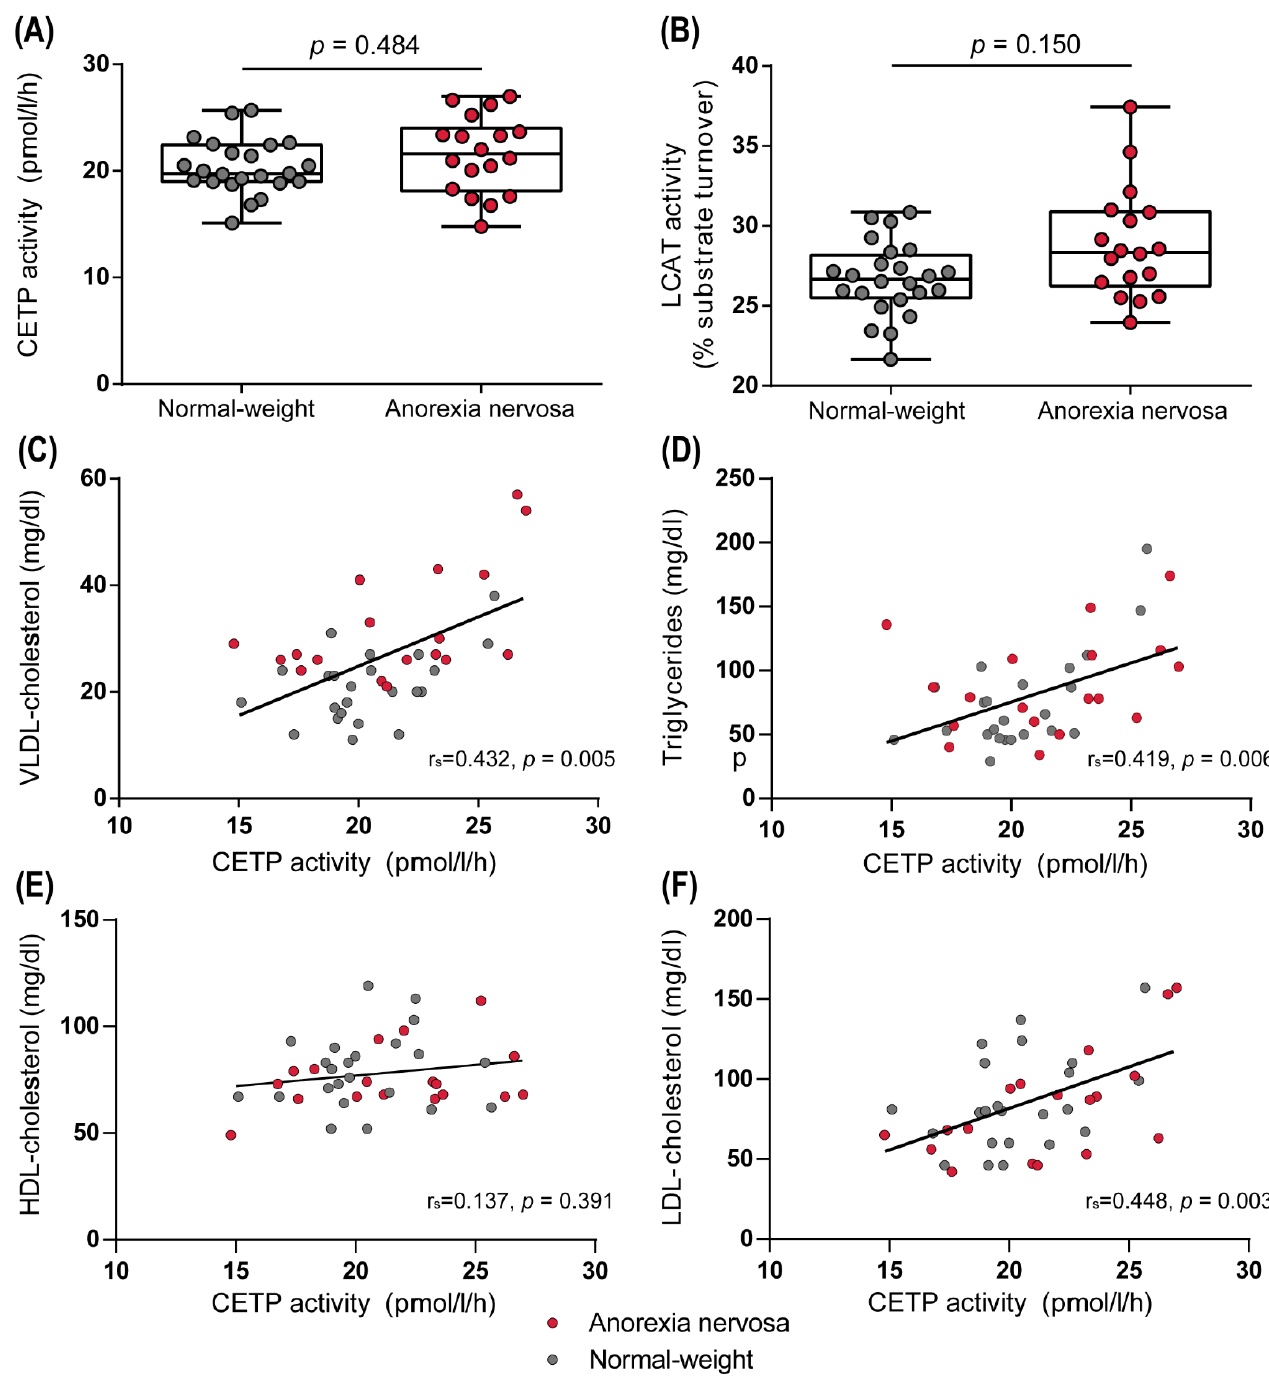
Figure 6. Activities of important enzymes in HDL metabolism are affected in anorexia nervosa. The activities of cholesteryl-ester transfer protein (CETP) ( A ) and lecithin-cholesteryl acyltransferase (LCAT) ( B ) were assessed in serum samples from the study population. Correlation analysis between CETP activity and plasma lipid levels was performed ( C – F ). Depending on the normal distribution of the data, t-test or Mann–Whitney U test was used to analyze differences between the two groups. Individual data are presented on top of boxplots, showing median, interquartile range, as well as minimum and maximum values. Adjusted p -values according to Benjamini–Hochberg are displayed.